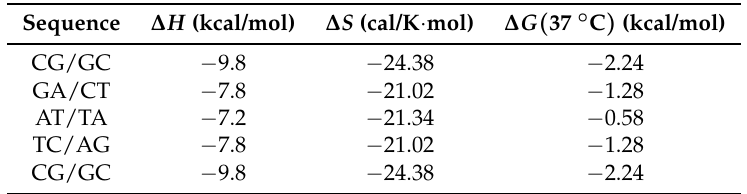
Table A1. Hybridization enthalpies ∆ H , entropies ∆ S and free energies ∆ G at T = 37 ◦ C for